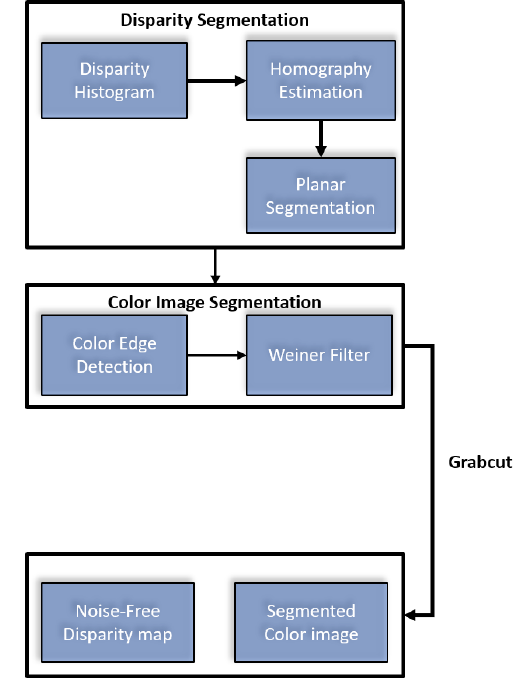
Figure 1. workflow of the proposed